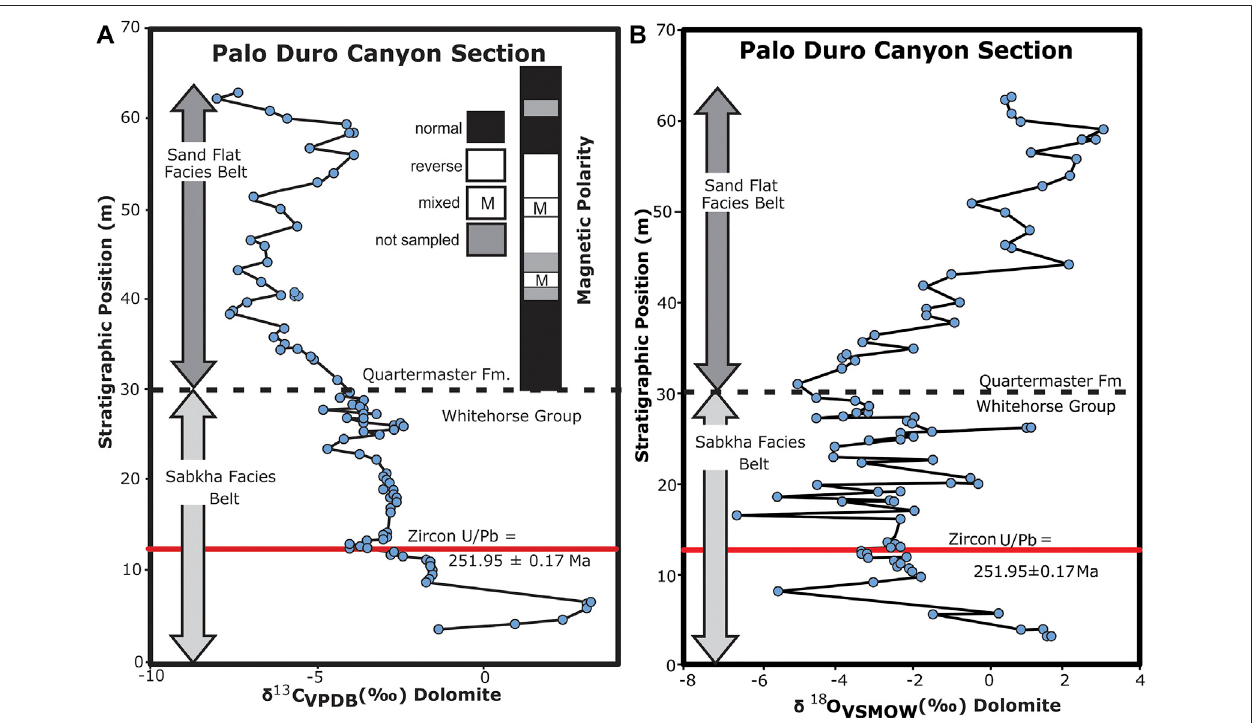
FIGURE 11 | (A) Chemostratigraphic chart of the stratigraphic position vs. dolomite δ 13 C value of dolomicrite cements from the Palo Duro Canyon stratigraphic section. (B) Chemostratigraphic chart of the stratigraphic position vs. dolomite δ 18 O value of dolomicrite cements from the Palo Duro Canyon stratigraphic section. The red and dashed black lines in both graphs represent the position of a radioisotopically dated volcanic ash and the formational contact between the lower Whitehorse Group strata and upper Quartermaster Formation strata, respectively. See text for detailed discussion.